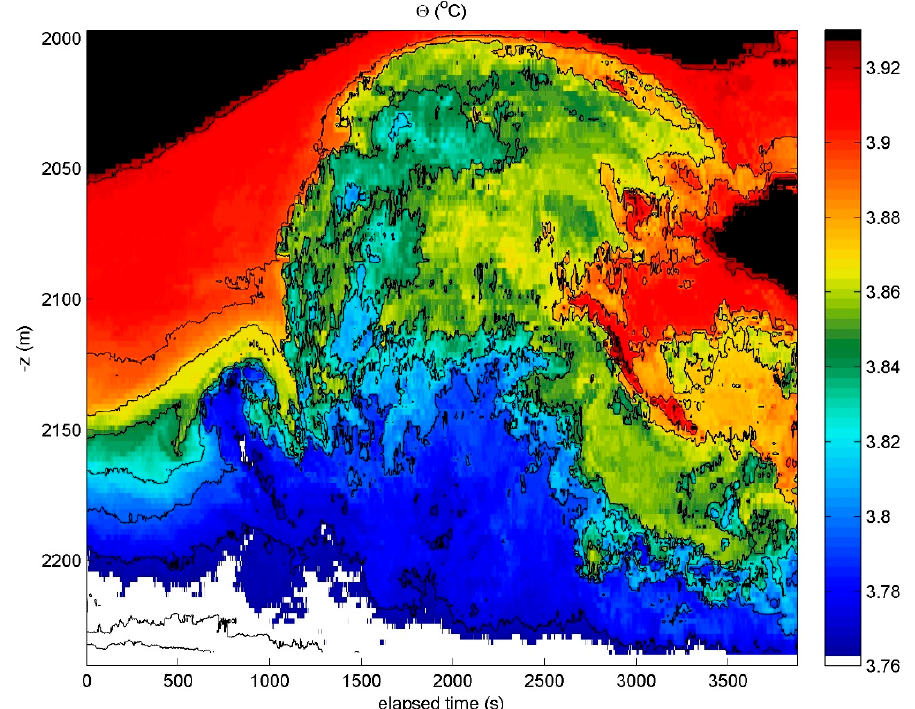
Figure 6. A one-hour, 200-m high upshot of a high-frequency internal wave breaking with turbulent fingers reaching out, which is measured using high-resolution T-sensors moored above a 2200 m deep slope of the Rainbow Ridge, North-Atlantic Ocean. The horizontal axis is at the sea floor. Hokusai-san [32] was right. If he could have looked into the ocean interior, the perspective would have been spot-on with the larger and smaller fingers grasping at the end of the overturning wave (here around 3000 s, 2050 m).